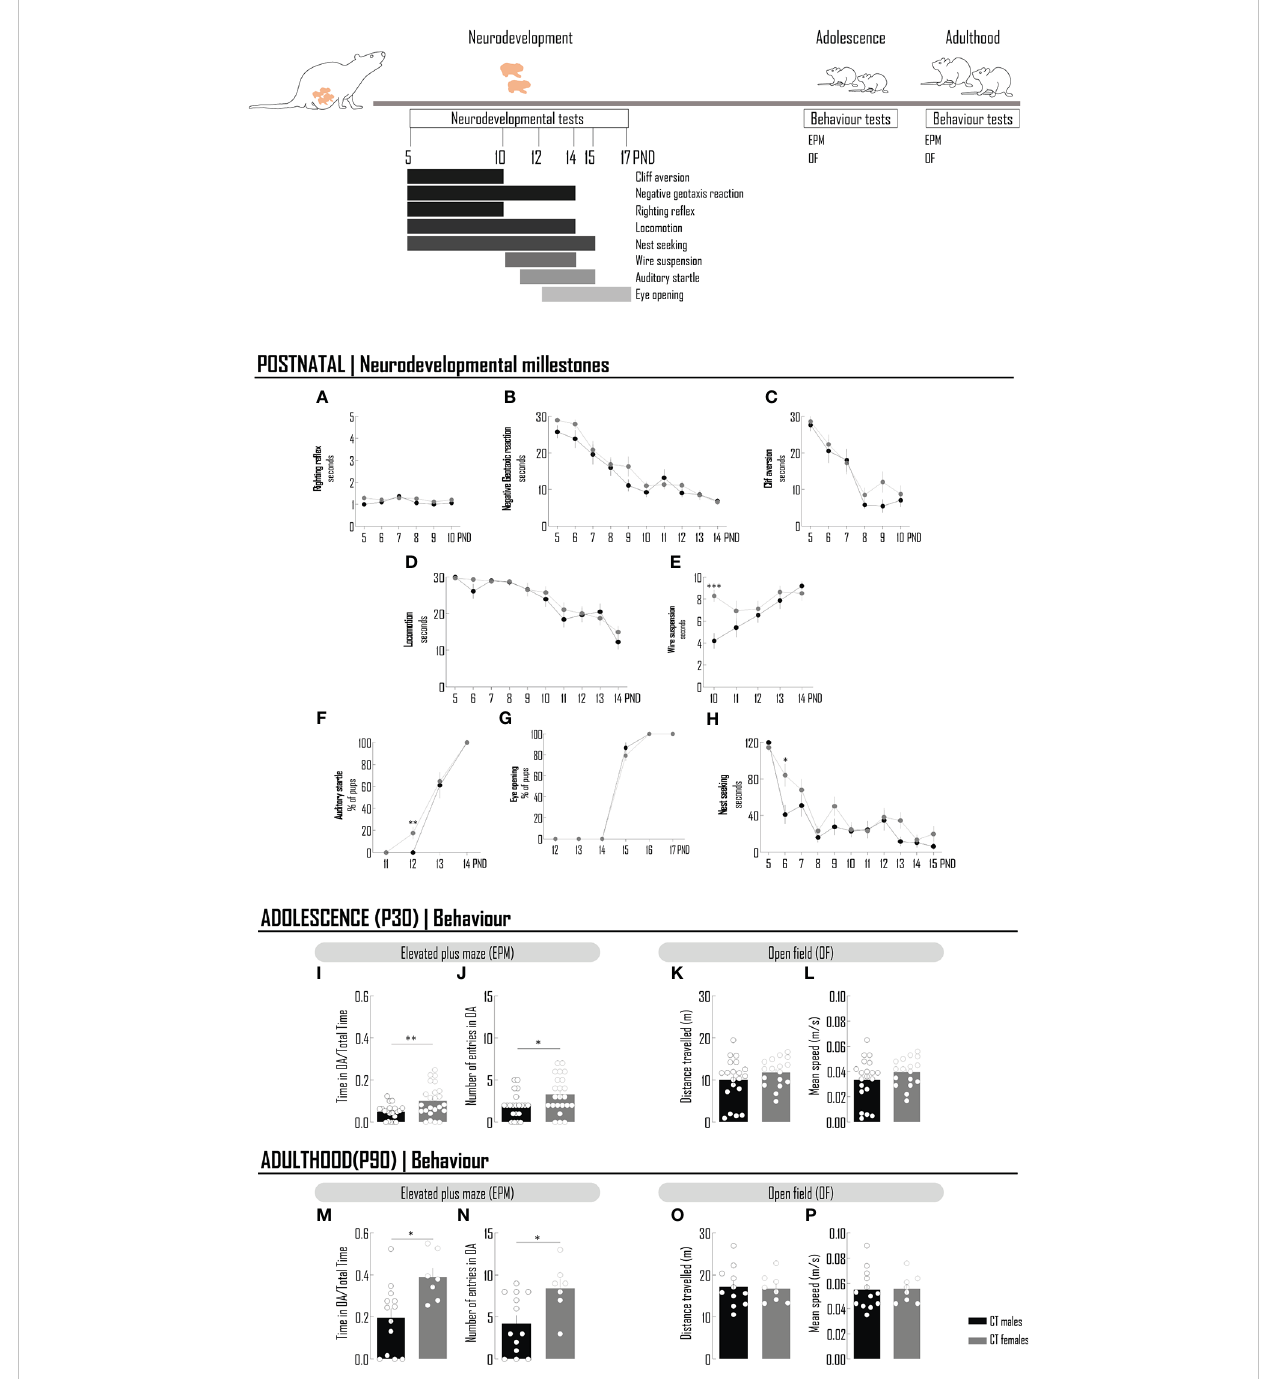
FIGURE 2 The behavior of rats in the anxiogenic environment of the elevated plus maze is different between sexes. Chronology of the neurodevelopmental milestones and behavioral tests performed in animals at postnatal period, adolescence and adulthood. A battery of neudevelopmental tests were conducted to evaluated re fl exes - righting re fl ex (A) , negative geotaxis reaction (B) and cliff aversion (C) , motor skills - locomotion (D) and wire suspension (E) , sensorial system - auditory startle (F) , eye opening (G) and social behavior – nest seeking (H) . To the majority of tests, latency to achieve the goal was recorded (A – D, E, H) . For auditory startle (F) and eye opening (G) , the percentage of pups was determined. At adolescence (I – L) and adulthood (M – P) , the elevated plus maze and open fi eld tests were performed. To evaluate the performance in an anxiogenic context, the time spent in OA per total time of the EPM test (I, M) and the number on entries in the OA (J, N) were recorded. Locomotion was assessed by measuring the distance travelled (K, O) and the mean speed (L, P) . Results are presented as mean ± SEM. *p<0.05 comparing CT males and females. EPM, elevated plus maze; OA, open arms; OF, open fi